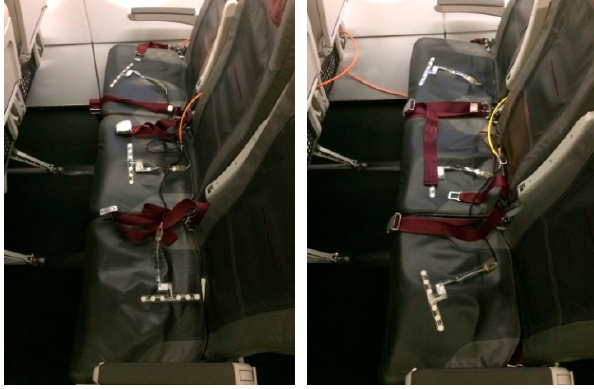
Figure 19. Seat sensors in a field trial environment.